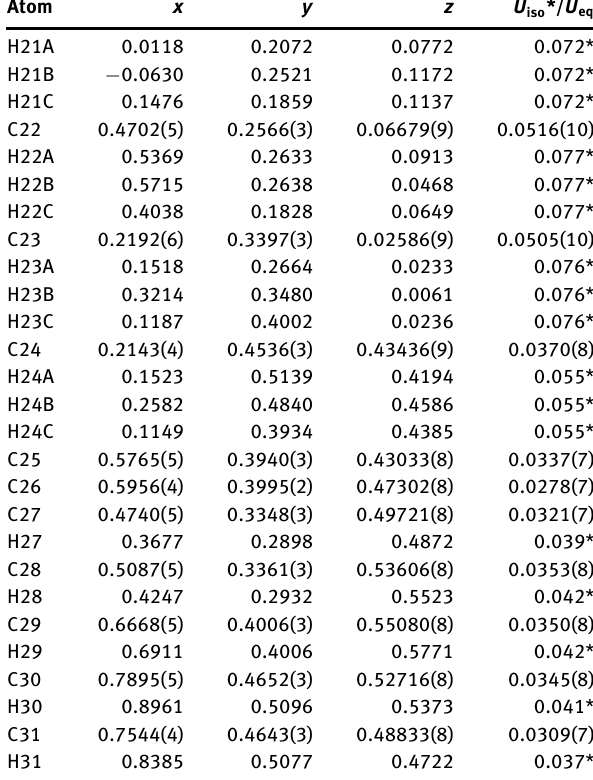
Table 2: Fractional atomic coordinates and isotropic or equivalent isotropic displacement parameters (Å 2